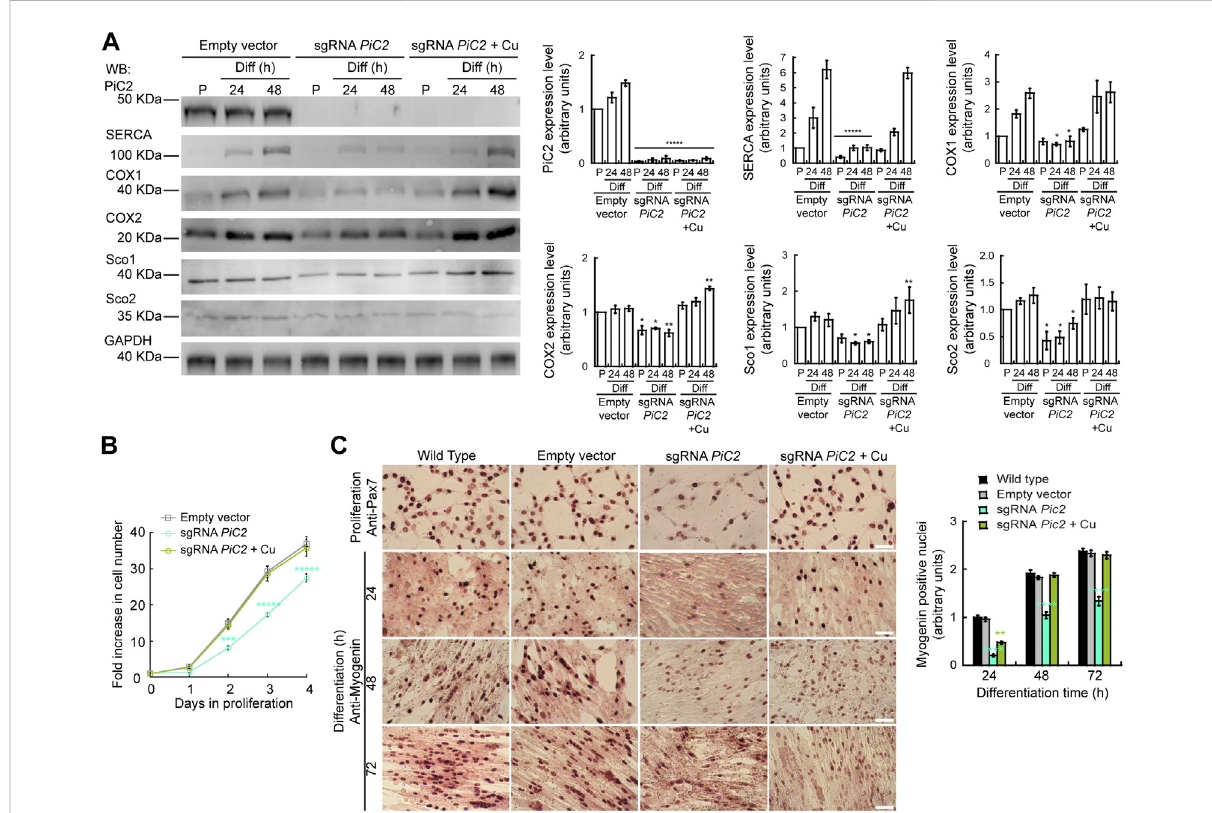
FIGURE 5 Deletion of mPiC2 impairs the proliferation and differentiation of primary myoblasts derived from mouse satellite cells. (A) Deletion of mPiC2 reduces the expression of mitochondrial cuproproteins. Representative western blot of mPiC2 and mitochondrial cuproproteins in control cells(emptyvector)orcellsinwhichCRISPR/Cas9wasusedtodeletemPiC2(sgRNA PiC2 )orKOcellssupplementedwithCuSO 4 (sgRNA PiC2 +Cu) during proliferation (P) and at 24 h and 48 h after inducing differentiation. GAPDH was used as a loading control. Plots represent the quanti fi cation of each protein analyzed from three independent biological replicates. Values are the means ± SEM. Signi fi cance was determined by two-way ANOVA; * p < 0.05, ** p < 0.01 and **** p < 0.0001 vs. empty vector at the corresponding timepoint. (B) Deletion of mPiC2 delays proliferation. Cell counting assay of empty vector, sgRNA against PiC2 , and sgRNA PiC2 + Cu cells at different points during proliferation. n = 3. All values are reported as means ± SEM. Signi fi cance was determined by two-way ANOVA; *** p < 0.001 and **** p < 0.0001 comparedto empty vector cells. (C) DeletionofmPiC2delaysmyogenesis.Stainingofwildtype,emptyvector,sgRNA mPiC2 ,andsgRNA mPiC2 +Cucellswitheitheranti-Pax7